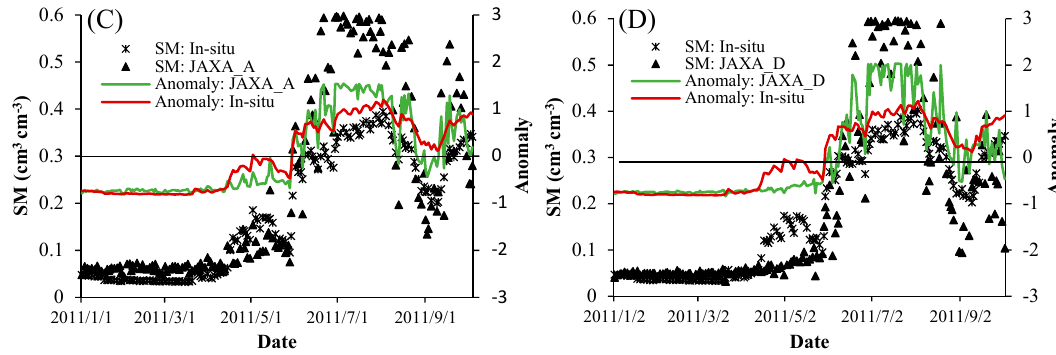
Figure 7. Intra-annual variation and relative anomaly of AMSR-E / NASA, JAXA SM data and in-situ SM measurements in Pixel 1, 2011: ( A ) AMSR-E / NASA during ascending orbits and ( B ) descending orbits; ( C ) AMSR-E / JAXA during ascending orbits, and ( D ) descending orbits. Table 2. Calculated MAE, RMSE, and R of SM data in the Naqu area against in-situ SM measurements in 2011; st. dev are the standard deviation of each SM data product for each pixel,